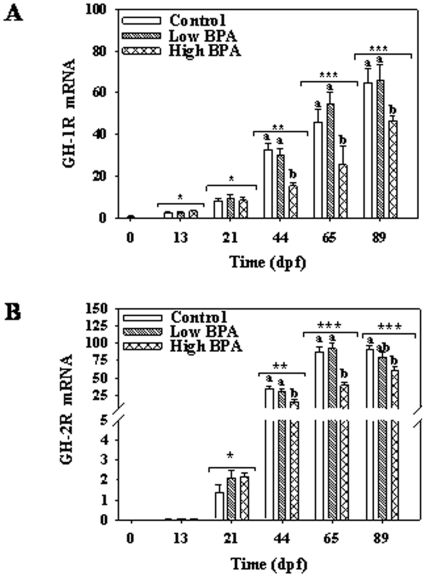
Impact of bisphenol A (BPA) on growth hormone (GH) receptors gene expressions.Temporal changes in GH-1 receptor (GH-1R; A) and -2 receptor (GH-2R; B) mRNA abundances during rainbow trout development. See Fig. 2 legend for experimental details. Maternal transcript levels were measured in freshly fertilized eggs and represented as 0 dpf (dark colored bar). Two-way ANOVA was used to determine the effect of time, treatment and interaction effects on the transcript levels during development (Bonferonni posthoc test; p<0.05). Different letters represent differences between treatments at each time point. Asterisk (*) represent effect of time on the transcript levels. All values represent mean + SEM (n = 7 fish).